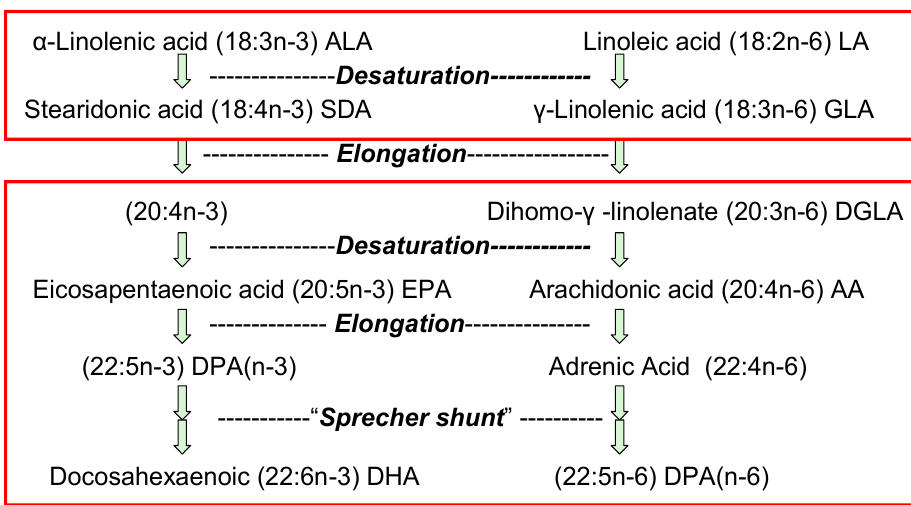
Figure 1. Competition between n -6 and n -3 forms of essential fatty acids (EFA). Typical daily amounts of these acids eaten in the USA as percent of food energy (en%) are for 18-carbon EFA 7% n -6 acids (18:2 n -6 + 18:3 n -6) and 1% n -3 acids (18:3 n -3 + 18:4 n -3), but for 20- and 22-carbon HUFA they are only 0.08% n -6 acids (20:3 n -6, 20:4 n -6, 22:4 n -6 + 22:5 n -6) and 0.04% n -3 acids (20:5 n -3, 22:5 n -3 + 22:6 n